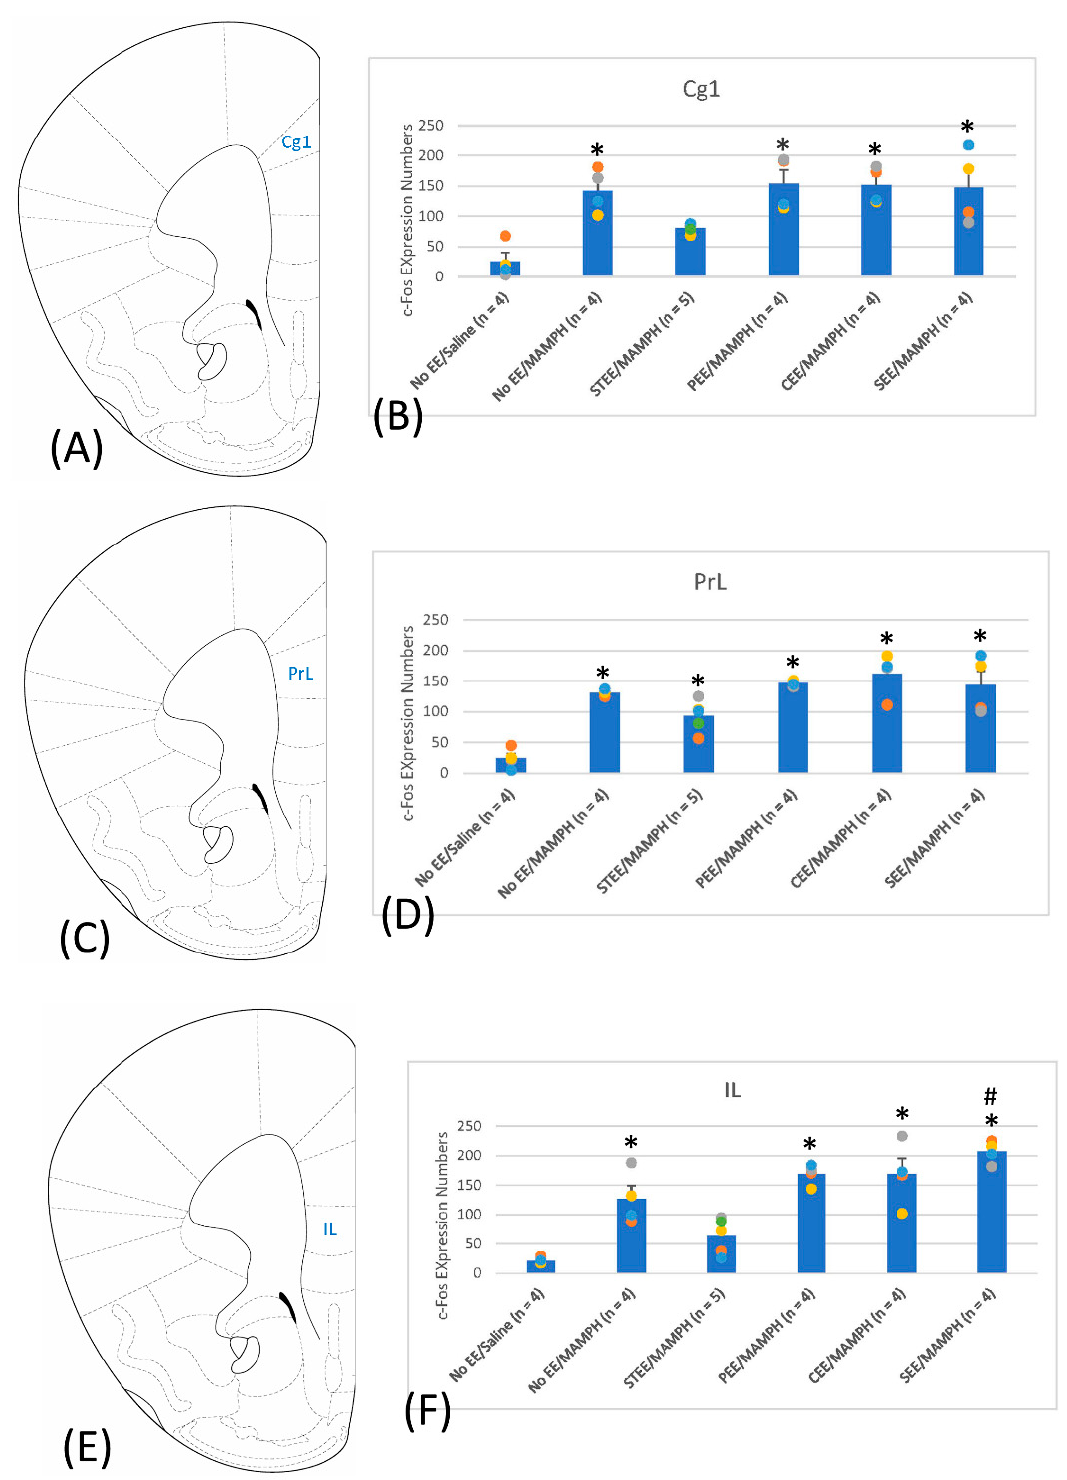
Figure 2. A cartoon brain atlas showing ( A ) the cingulate cortex 1 (Cg1), ( C ) prelimbic cortex (PrL), and ( E ) infralimbic cortex (IL) and c-Fos expression in ( B ) the Cg1, ( D ) PrL, and ( F ) IL for the No environmental enrichment (EE)/Saline ( n = 4), No EE/methamphetamine (MAMPH; n = 4), standard EE (STEE)/MAMPH ( n = 5), physical EE (PEE)/MAMPH ( n = 4), cognitive EE (CEE)/MAMPH ( n = 4), and social EE (SEE)/MAMPH ( n = 4) groups; * p < 0.05 compared with the No EE/Saline group, and # p < 0.05 compared with the No EE/MAMPH group.